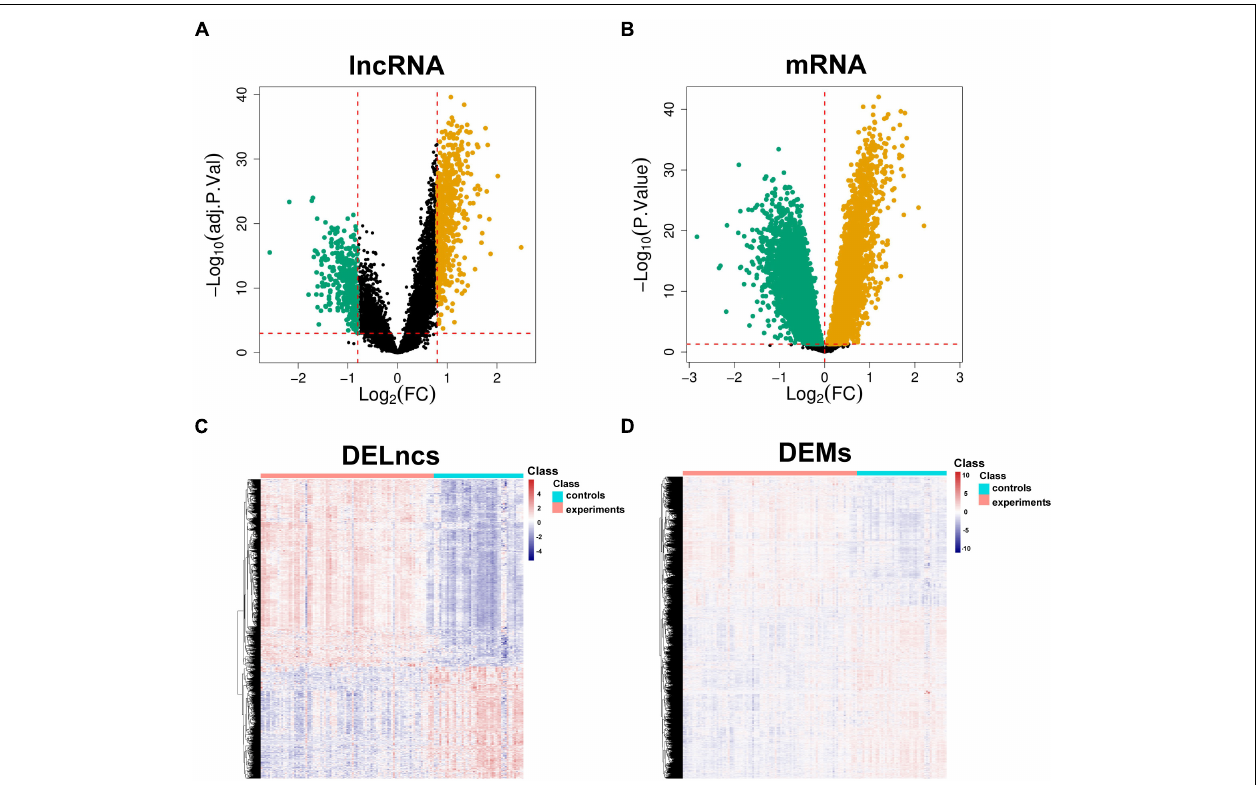
FIGURE 2 | Identification of aberrantly expressed molecules. Volcano plots of DELncs (A) and DEMs (B) in the CAD samples and controls. Heatmaps of DELncs (C) and DEMs (D) . Brown and green points correspond to upregulated and downregulated molecules, respectively, and black points indicate that there are no differences in the expression levels of the molecules. DELncs, differentially expressed lncRNAs; DEMs, differentially expressed mRNAs; CAD, coronary artery disease.